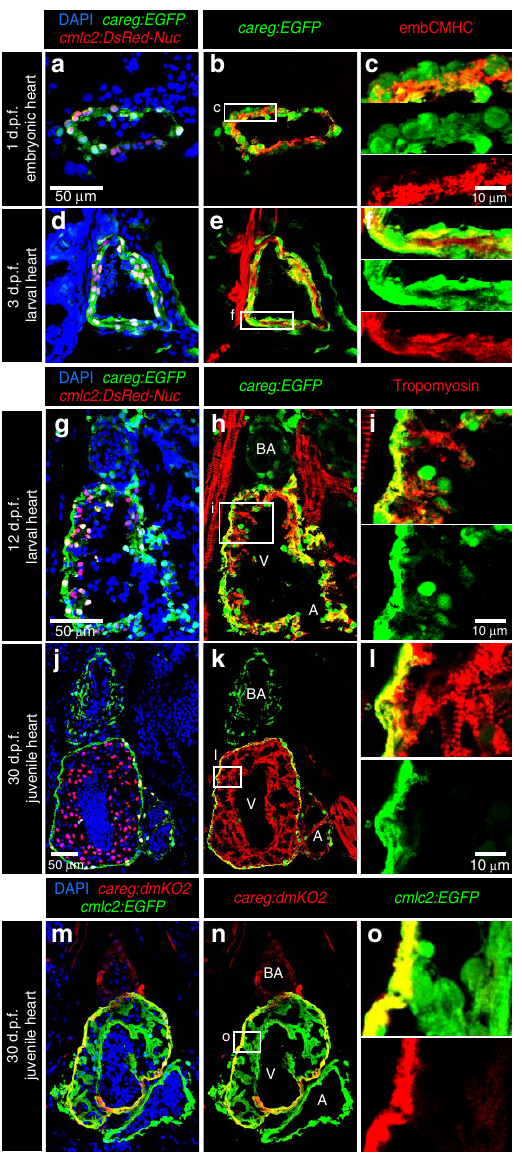
Figure 6 | careg is expressed in embryonic CMs and the outer wall of developing ventricle. ( a – l ) Longitudinal sections of careg:EGFP;cmlc2:DsRed2- Nuc double transgenic hearts at different time points during development. Cardiac nuclei are marked by DsRed expression. The endogenous fluorescence was quenched with HCl treatment before immunostaining. GFP and DsRed were detected by antibody staining. ( a – f ) At 1 and 3 d.p.f. (days post-fertilization), careg:EGFP and endogenous embCMHC are co-